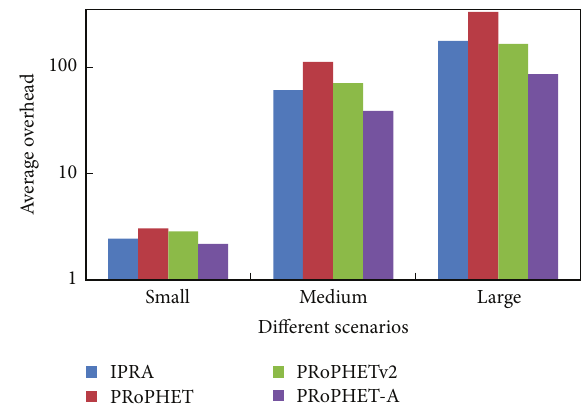
Figure 14: Average overhead (AO) under different